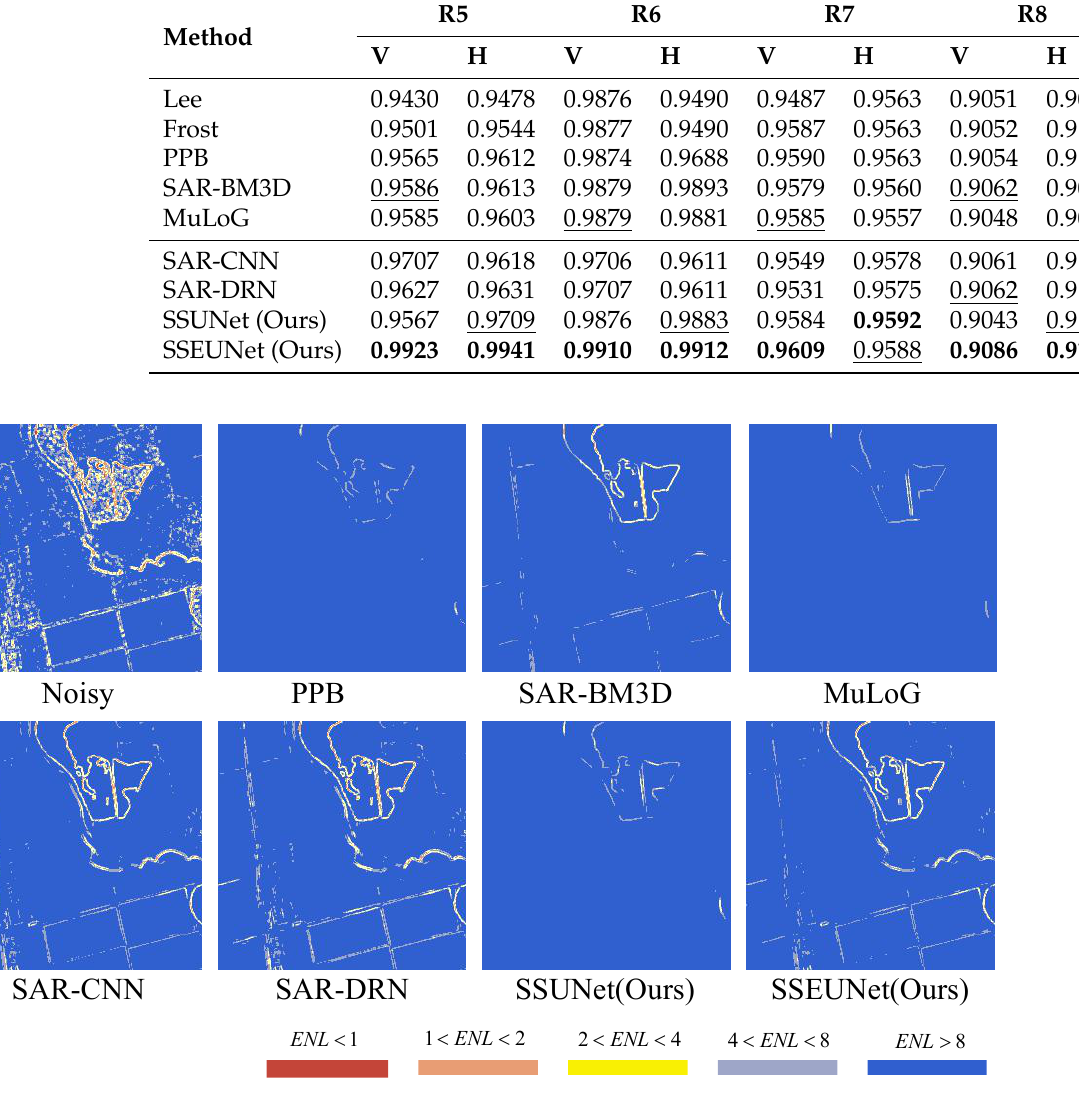
Table 4. ER metric on real-world SAR images.